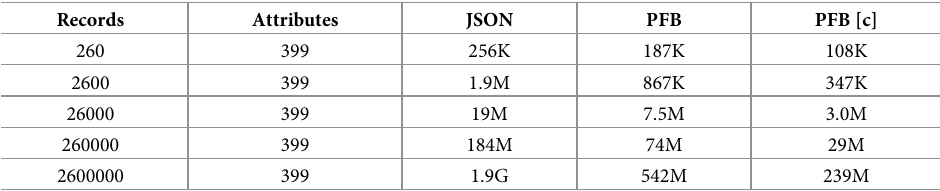
Table 4. Size comparison between JSON and PFB, [c] denotes the data was